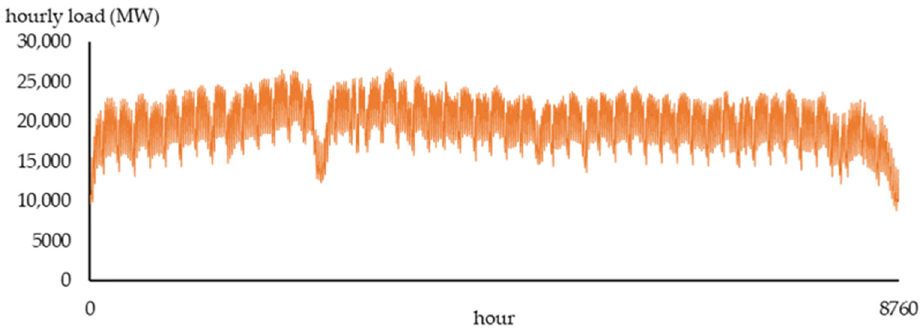
Figure 18. Hourly load profile for 8760